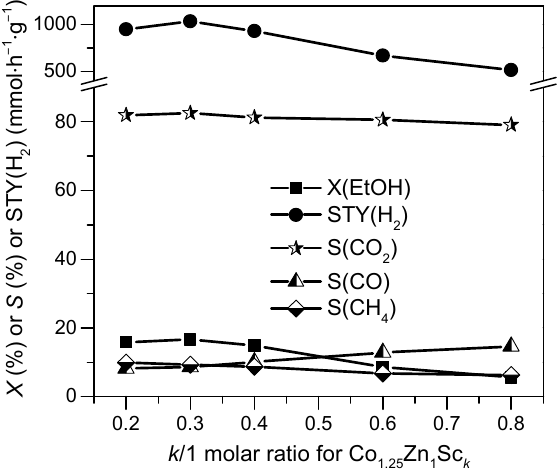
Figure 1. Performance of Co 1.25 Zn 1 Sc k catalyst for ethanol steam reforming (ESR) to H 2 as a function of Sc molar ratio. Reaction conditions: 0.5 MPa pressure, 723 K temperature, 15/45/40 molar ratio of EtOH/H 2 O/N 2 , and 150,000 mL·h − 1 ·g -cat − 1 GHSV.